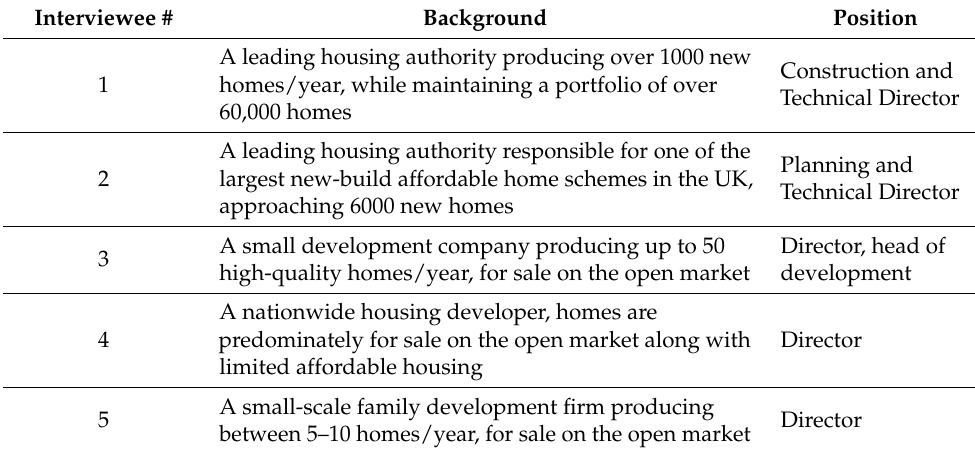
Table 3. Interviewees’ backgrounds, organisations and